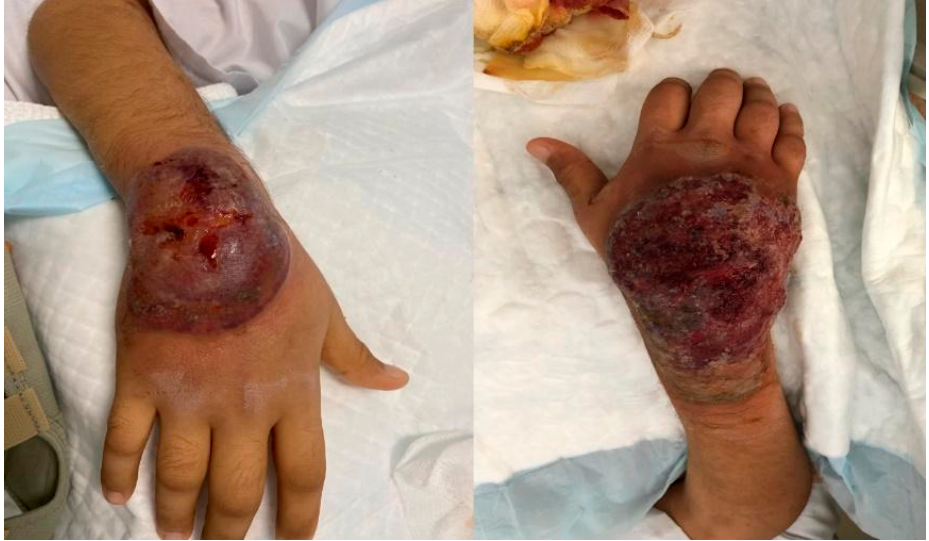
Figure 2. Progression and ulceration of lesion two days after appearance.